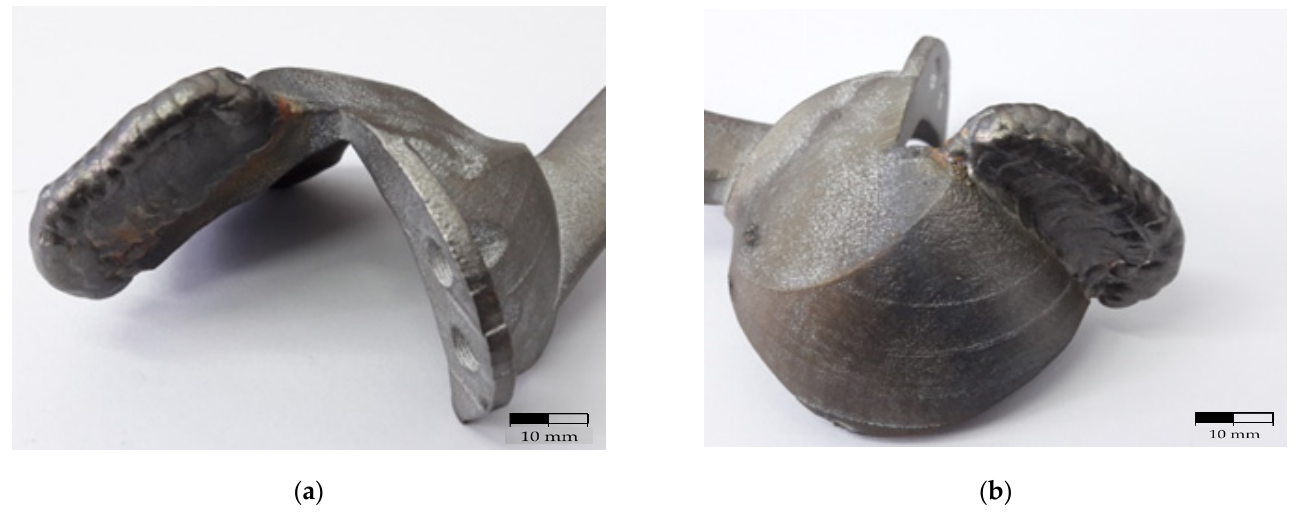
Figure 7. Custom implant subjected to the welding deposition process to restore the geometric characteristics prescribed by the 3D model. ( a ) front view; ( b ) back view.